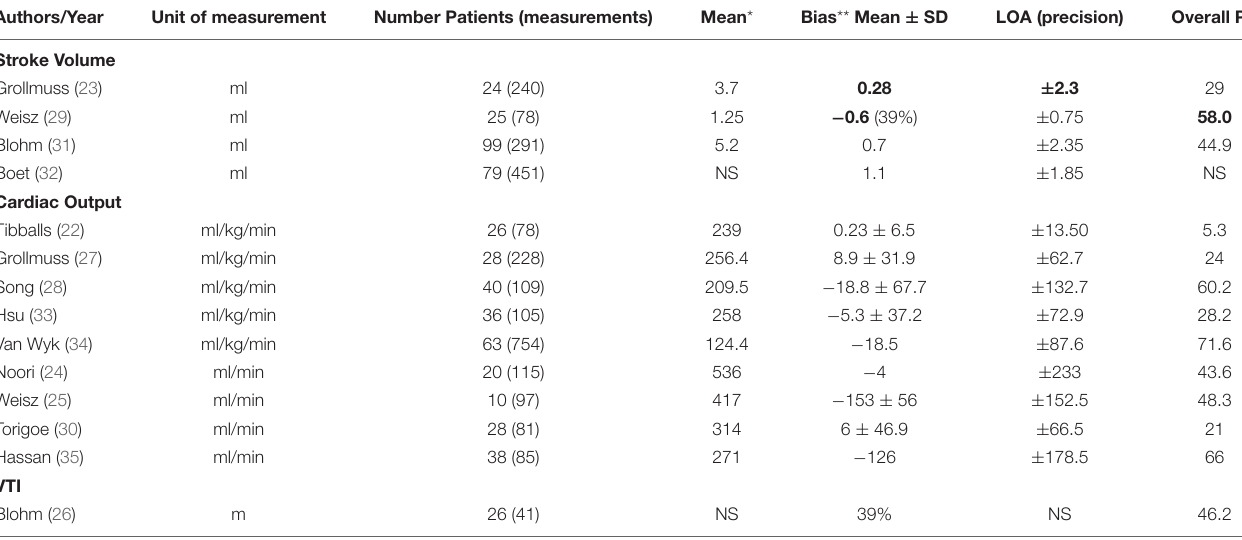
TABLE 3 | Overall data regarding accuracy and precision of TEBT and reference